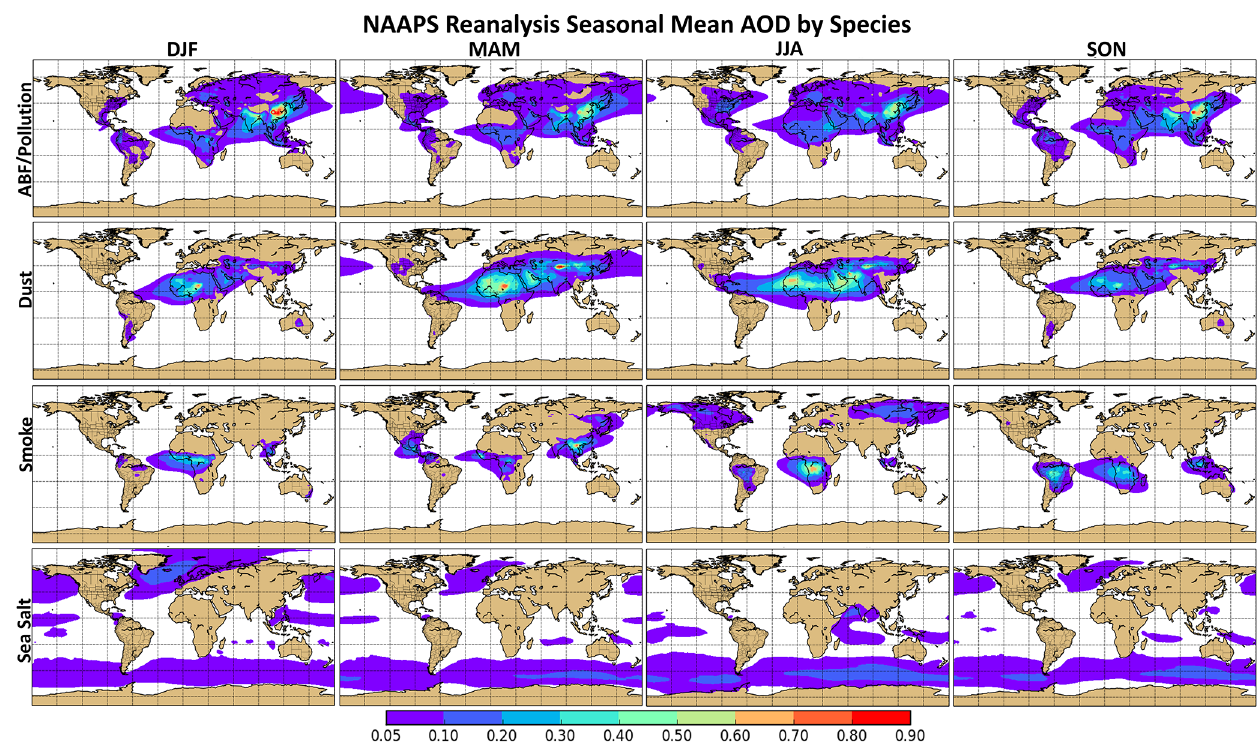
Figure 4. NAAPS-RA seasonally averaged AOD by aerosol type, including pollution (anthropogenic and biogenic fine aerosol), dust, smoke, and sea